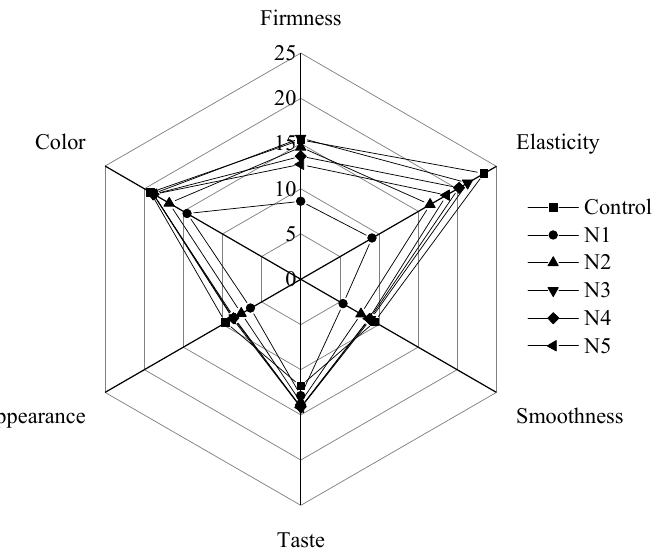
Figure 4. Sensory evaluation of cooked whole-wheat noodles. N1, N2, N3, N4, and N5 are noodles corresponding to wheat brans with decreases in particle size sequentially. The noodles made from refined wheat flour served as a control group.